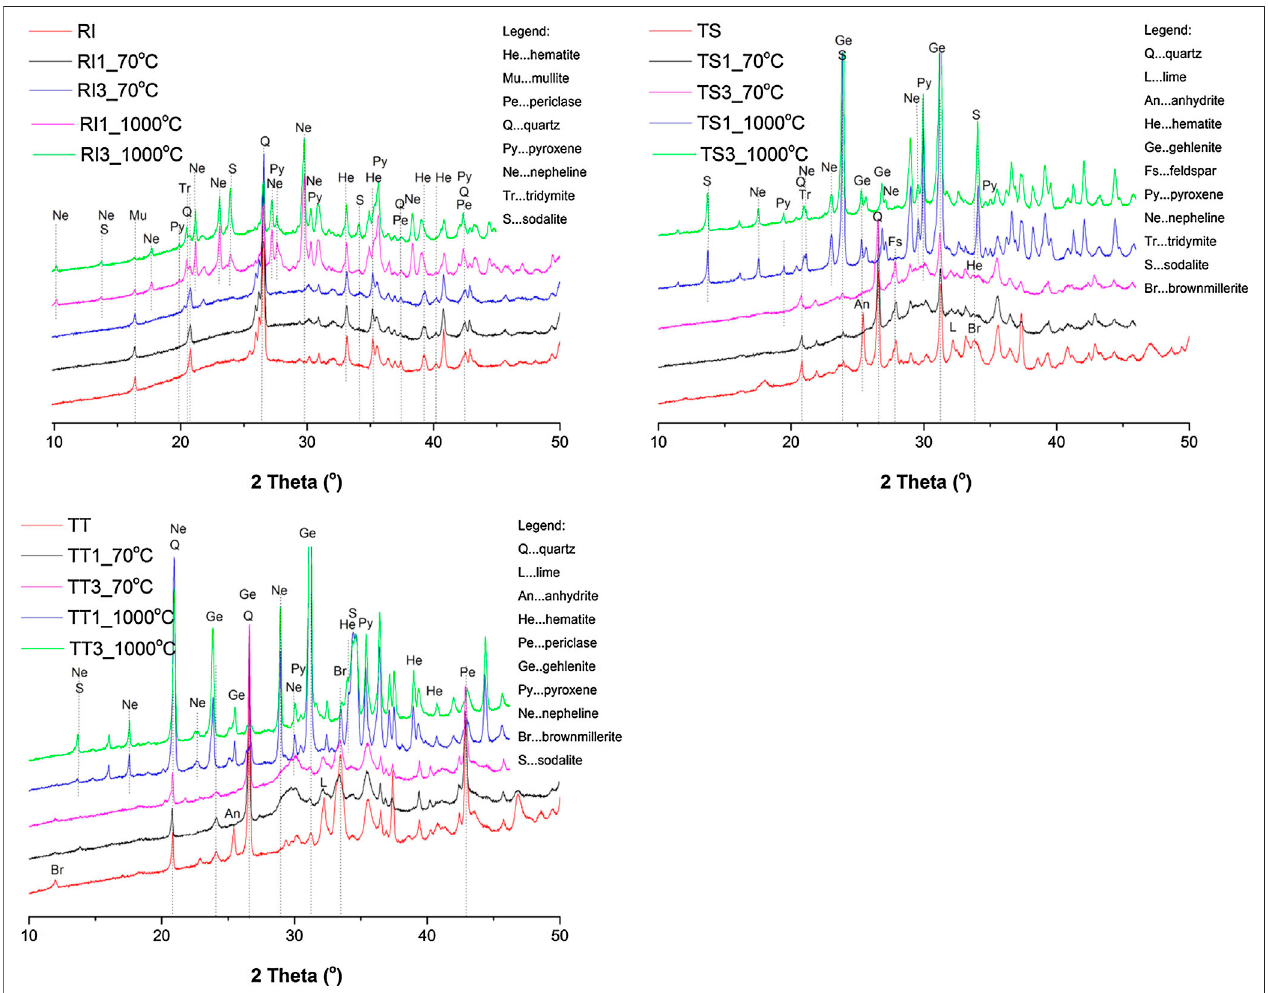
FIGURE 9 | Phase composition of the analyzed alkali-activated foams cured at 70 and 1,000 ° C (RI, TS, and TT fl y ash used, 1, 2, and 3 represent amount of foaming and stabilizing agents used), as determined by means of X-ray powder diffraction.